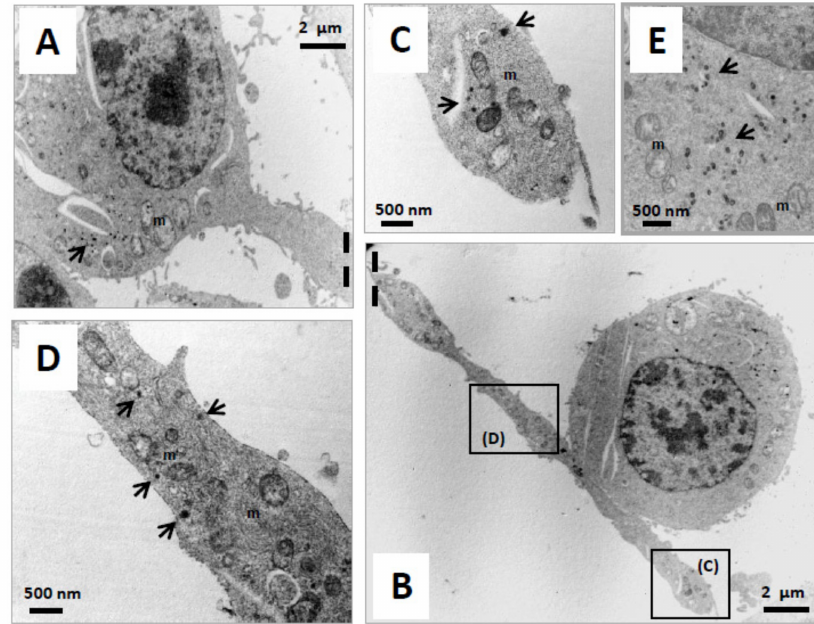
Figure 5. Visualization of mitochondria and peroxisomes in ODN-treated N2a cells by transmission electron microscopy. Murine neuronal N2a cells were previously cultured for 24 h in conventional cultured medium and further cultured for 48 h in medium without FBS in the presence of octadecaneuropeptide (ODN: 10 − 14 M). The preparations, which were contrasted with uranyl acetate and lead citrate, were also stained with DAB to visualize the peroxisomes. In ODN-treated N2a cells, isolated peroxisomes were rarely detected whereas clusters of peroxisomes are often observed (( A , E ); arrows ) in the soma; the diameters of the peroxisomes were in the range of 0.1 µ m ( E ). Due to the large length of the neurites (dendrites / axons), these structures are often separated from the soma (cell body) and present on the grid in a compartment adjacent to the one where the corresponding soma is detected (( A ): soma; ( B ): neurite). The simultaneous presence of mitochondria ( m ) and peroxisomes (dark arrow; diameter around 0.1 µ m) was revealed in a di ff erent area of the neurite ( C , D